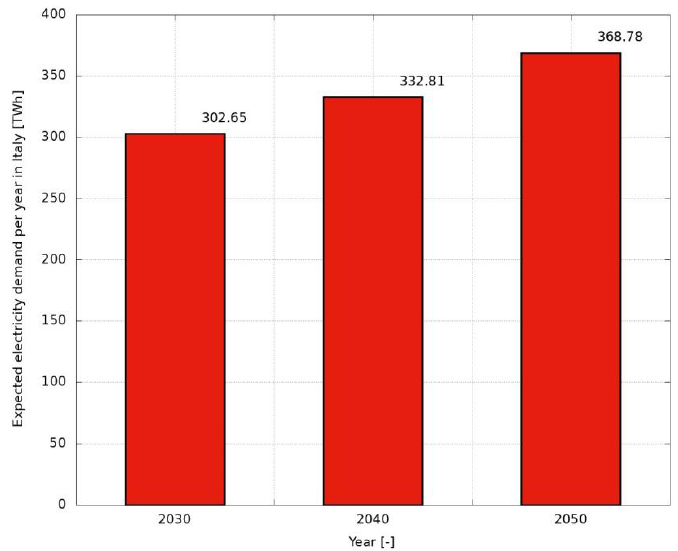
Figure 13. Expected electric energy production values per year in Italy.